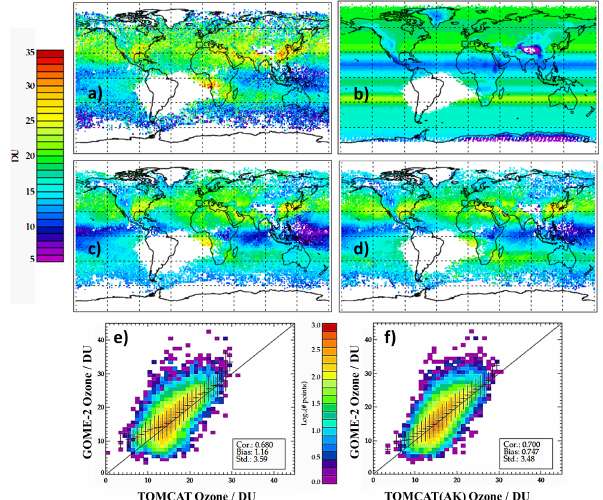
Figure 9. (a) GOME-2 surface to 450hPa layer ozone gridded (1.125) monthly mean for September 2008. Pixels have been strictly cloud-cleared such that only pixels with a cloud fraction of < 0.2 and cloud top pressure of > 700hPa remain; (b) a priori for GOME- 2 retrieval (all pixels); (c) TOMCAT model with satellite sampling, (d) TOMCAT model with GOME-2 averaging kernels also applied; (e) correlation of (a) and (c) with associated bias and standard de- viation; (f) correlation of (a) and (d) . The vertical and horizontal black lines in panels (e) and (f) indicate the respective standard de- viations of those data sampled along the TOMCAT axis, and the numbers of points in log 10 units are indicated by the colour